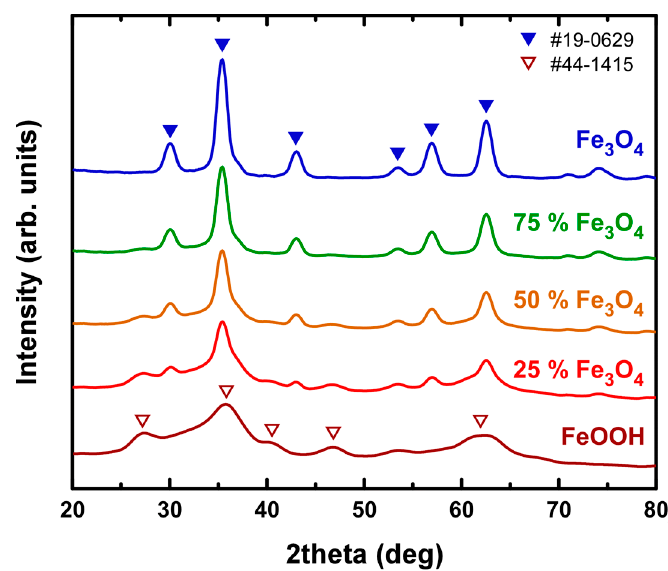
Figure 2. X-ray diffraction diagrams of studied Fe 3 O 4 /FeOOH nanocomposites. Triangles indicate the expected diffraction angles for magnetite and ferrihydrite from the ICDD/JCPDS PDF Database [23].